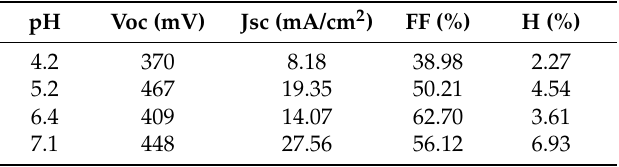
Figure 5. The current-voltage curves of CIGS solar cells with a window layer of Cl-doped ZnO films that were electrodeposited using electrolytes with four pH values of ( a ) 4.2, ( b ) 5.2, ( c ) 6.4, and ( d ) 7.1. Table 1. Performance parameters of CIGS solar cells with Cl-doped ZnO films that were prepared by various pH